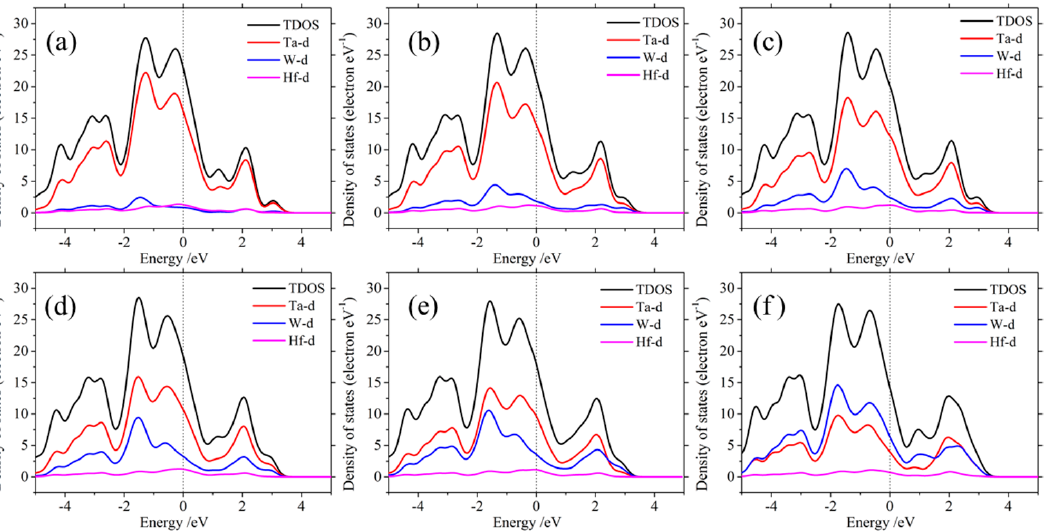
Figure 11. The partial density of states (PDOS) of Ta, W, and Hf atoms in Ta–W–Hf alloys: ( a ) Ta– 6.25W–6.25Hf, ( b ) Ta–12.5W–6.25Hf, ( c ) Ta–18.75W–6.25Hf, ( d ) Ta–25.00W–6.25Hf, ( e ) Ta–31.25W– 6.25Hf, ( f ) Ta–50.00W–6.25Hf.